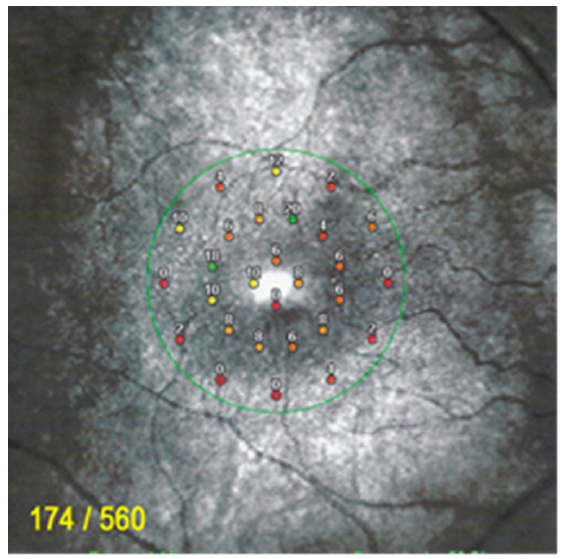
Figure 13. Microperimetry OD in AZOOR patient 3 at presentation. Severe loss of score reduced to